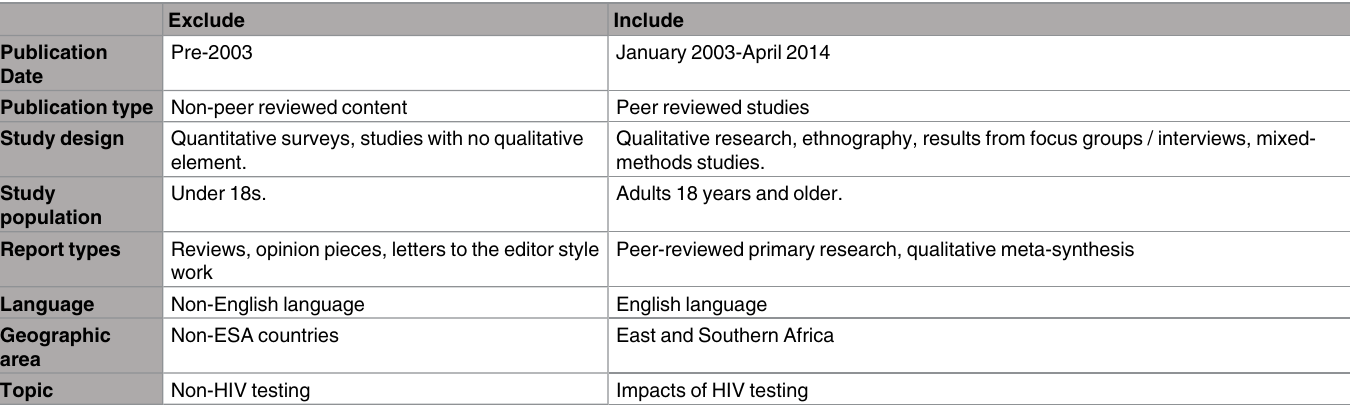
Table 2. Exclusion and inclusion